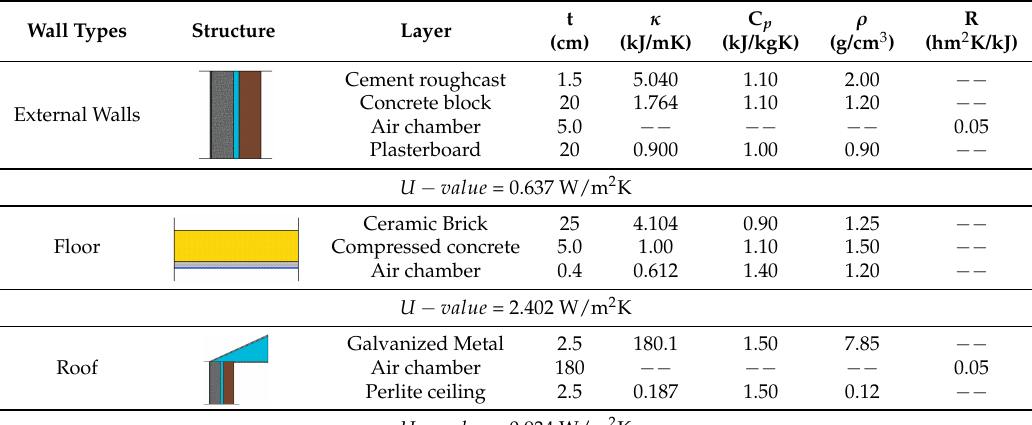
Table 1. Thermal and structural properties of adopted constructive solutions for case 1